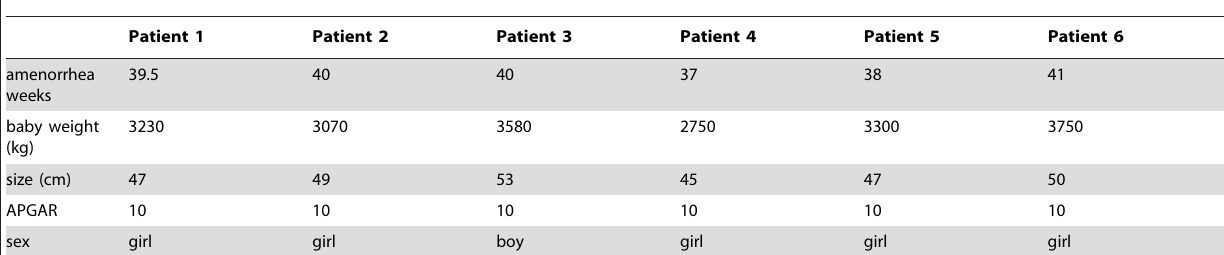
Table 2. Delivery and neonatal